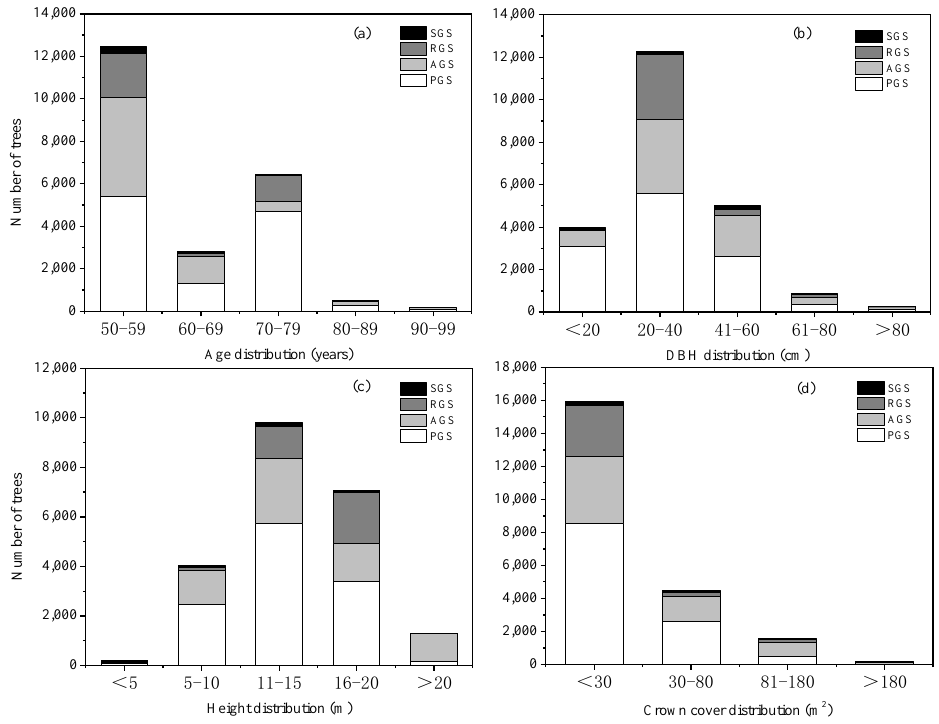
Figure 1. Age, DBH, height, and crown cover distribution of middle-aged trees. ( a ) Number of middle-aged trees in different age classes; ( b ) number of middle-aged trees in different DBH grades; ( c ) number of middle-aged trees in different height grades; ( d ) number of middle-aged trees in different crown cover grades. SGS, square green spaces; RGS, road green spaces; AGS, attached green spaces; PGS, park green spaces.